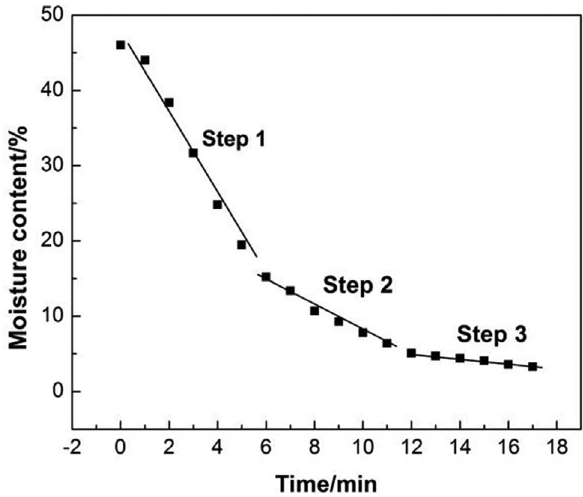
Figure 9: Optimized microwave drying process.